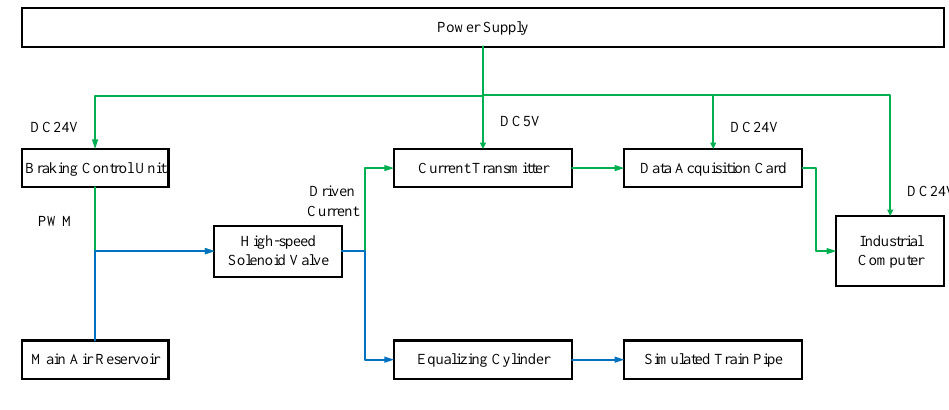
Figure 4. Accelerated aging test platform: ( a ) the accelerated aging test platform of the high-speed solenoid valve and ( b ) the generalized representation of the test platform, where the green lines are the signal flow and the blue lines are the air flow.